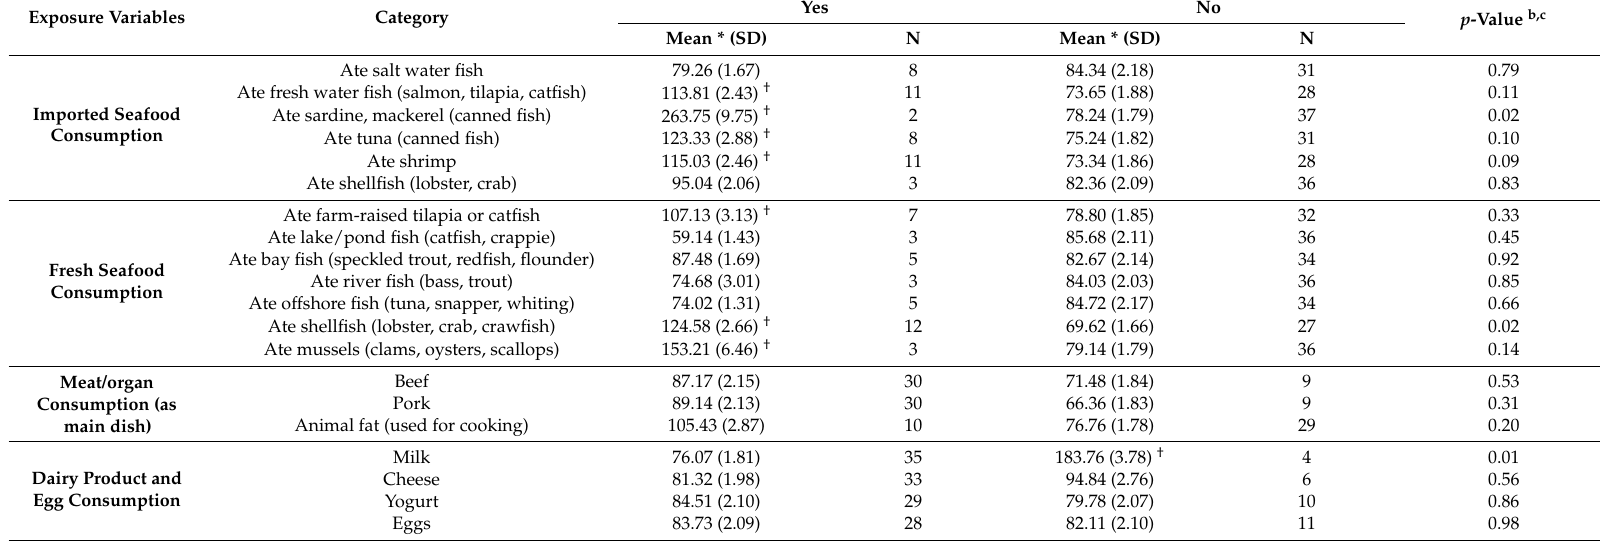
Table 4. Associations between dietary consumption and lipid-adjusted octa-chlorinated dioxin (OCDD) (pg/g) concentrations in serum (N = 39) a . Exposure